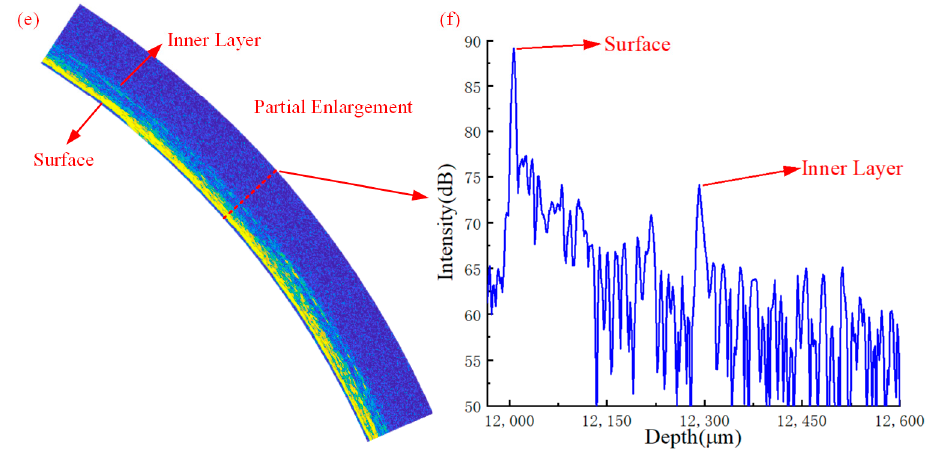
Figure 8. The tomographic image of the inner diameter liner: ( a ) the photo of the experimental sys- tem; ( b , c ) the diagram of the sliding bearing; ( d ) the tomographic image of the inner ring liner; ( e ) the partially enlarged view of ( d ); ( f ) the 1-D fi gure of the do tt ed line in ( e